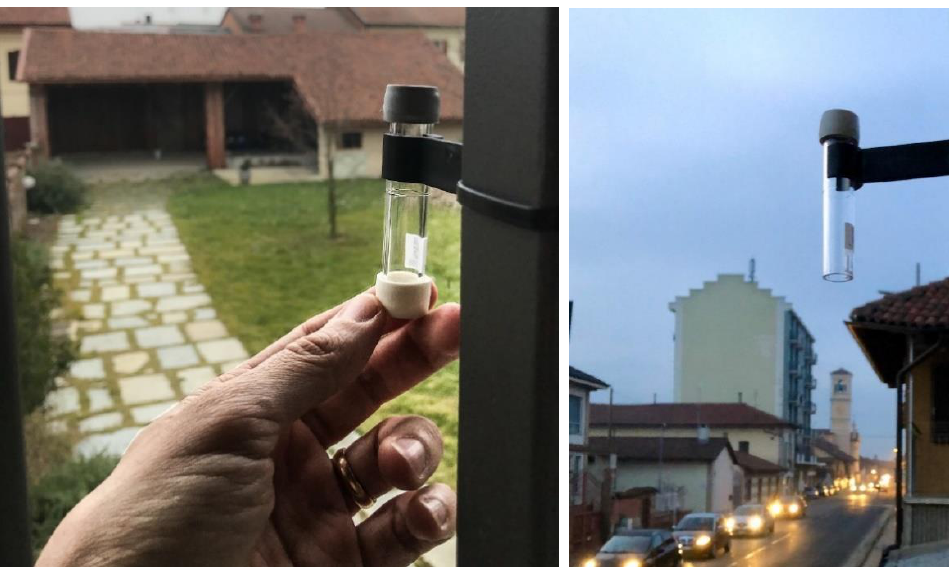
Figure 1. Passive sampler during installation ( left ) and operational ( right ) phases.